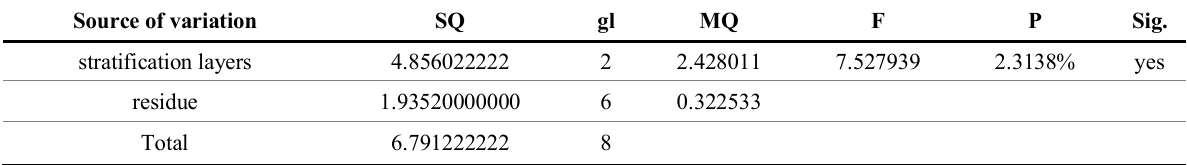
Table 4. Analysis of variance (ANOVA) – modulus of elasticity of the concrete Source of variation SQ gl MQ F P